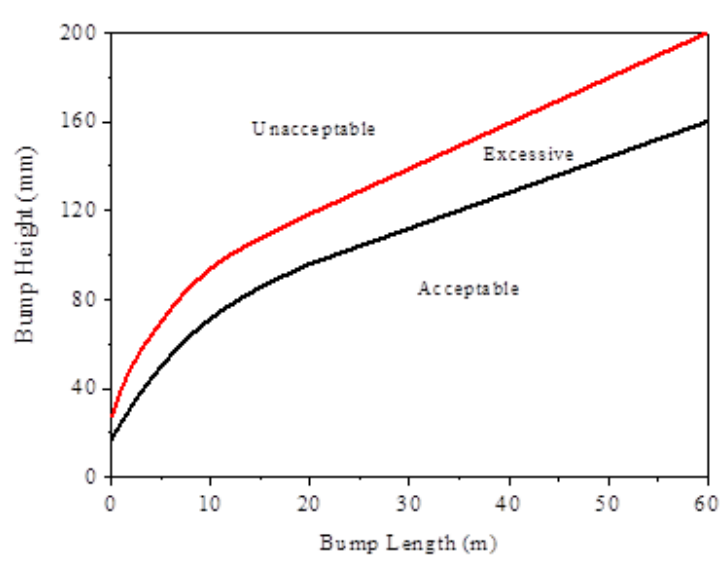
Figure 1. Classification standards of the Boeing